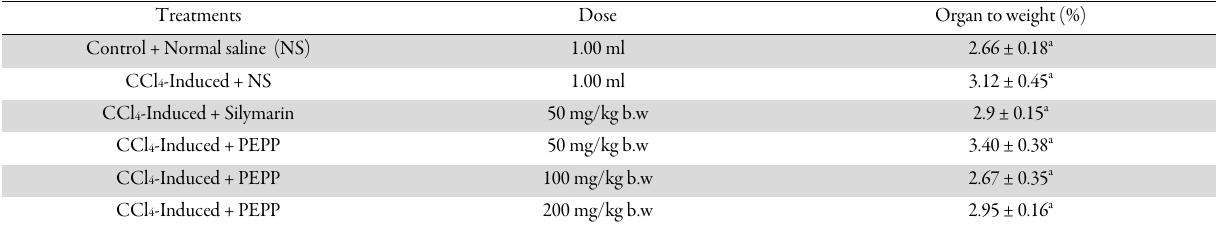
Table 1. Effects PEPP on liver to body weight ratio of CCl 4 -treated hepatotoxic rats Treatments Dose Organ to weight